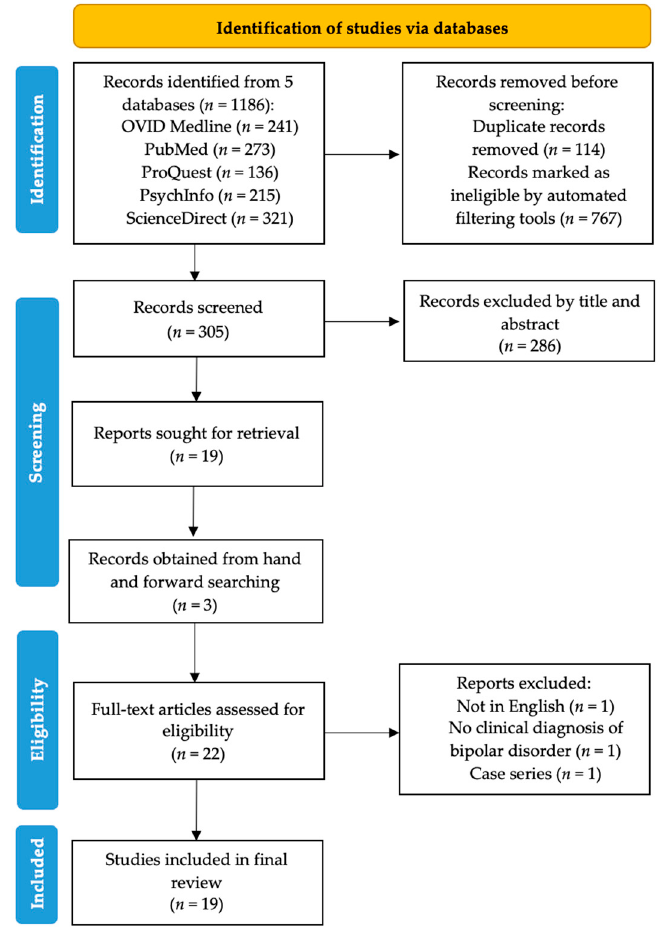
Figure 1. PRISMA flowchart showing the abstraction process.